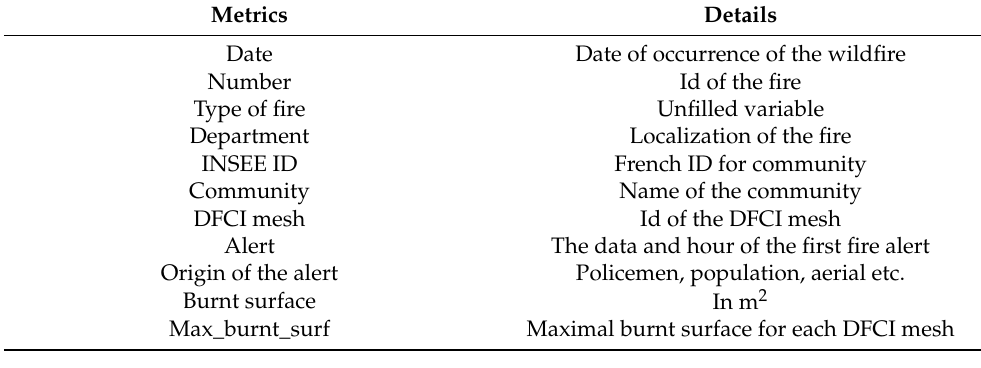
Table 1. Metrics of the Prometh é e database used for the study.